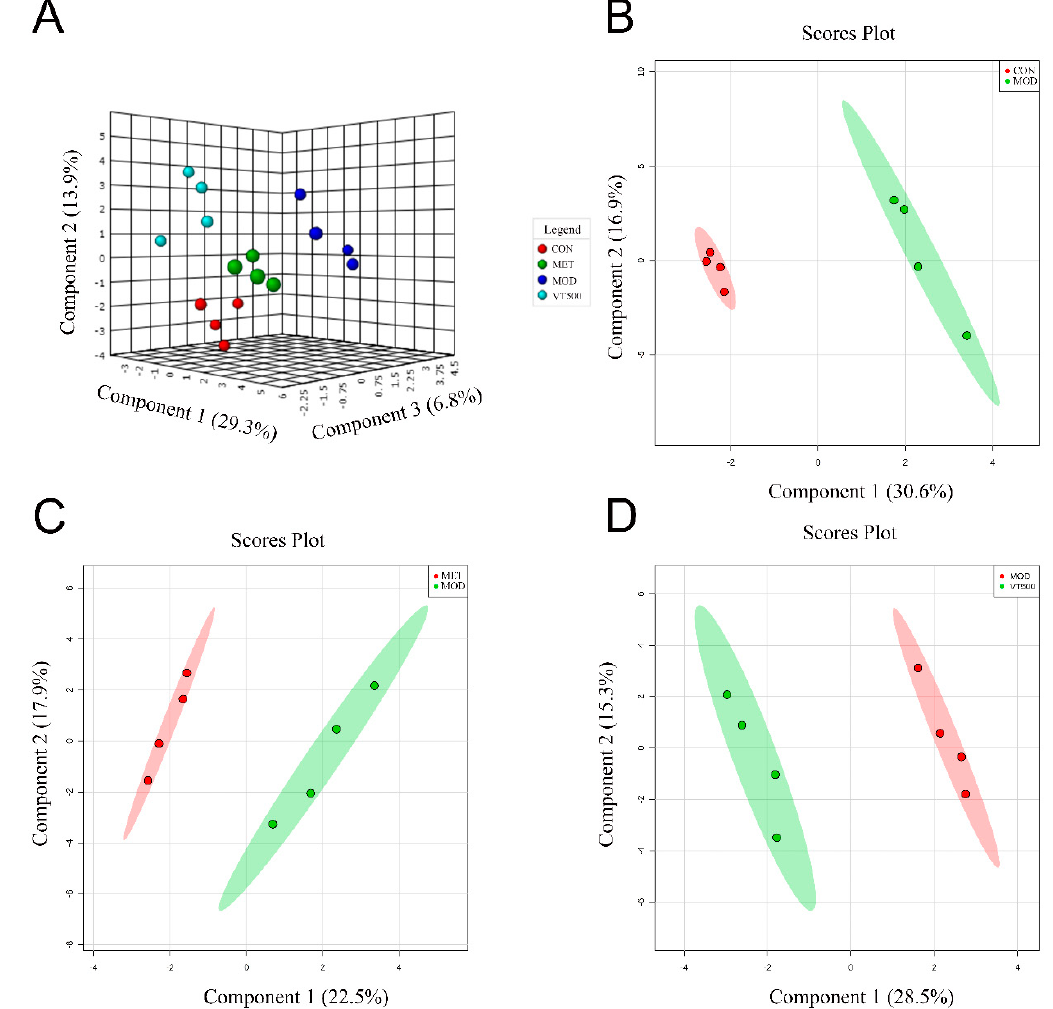
Figure 3. Effect of VT on liver metabolism in rats. Three-dimensional sparse partial least squares-discriminant analysis (sPLS-DA) of the CON, MOD, VT500 and MET groups ( A ); sPLS-DA score plots of all groups ( B ); sPLS-DA score plots of the MOD and MET groups ( C ); sPLS-DA score plots of the MOD and VT500 groups ( D ), n = 4.